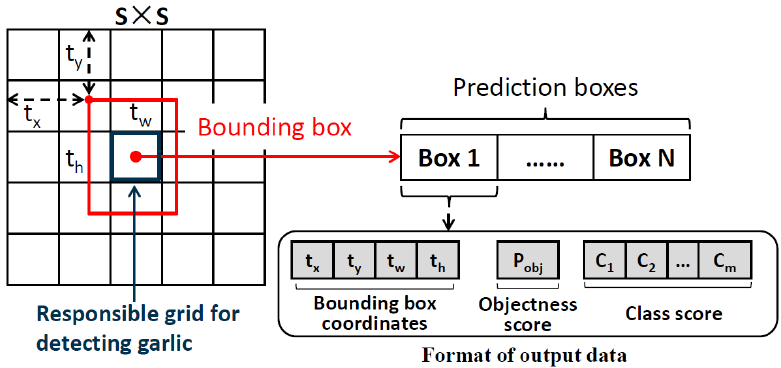
Figure 8. Model prediction layer.